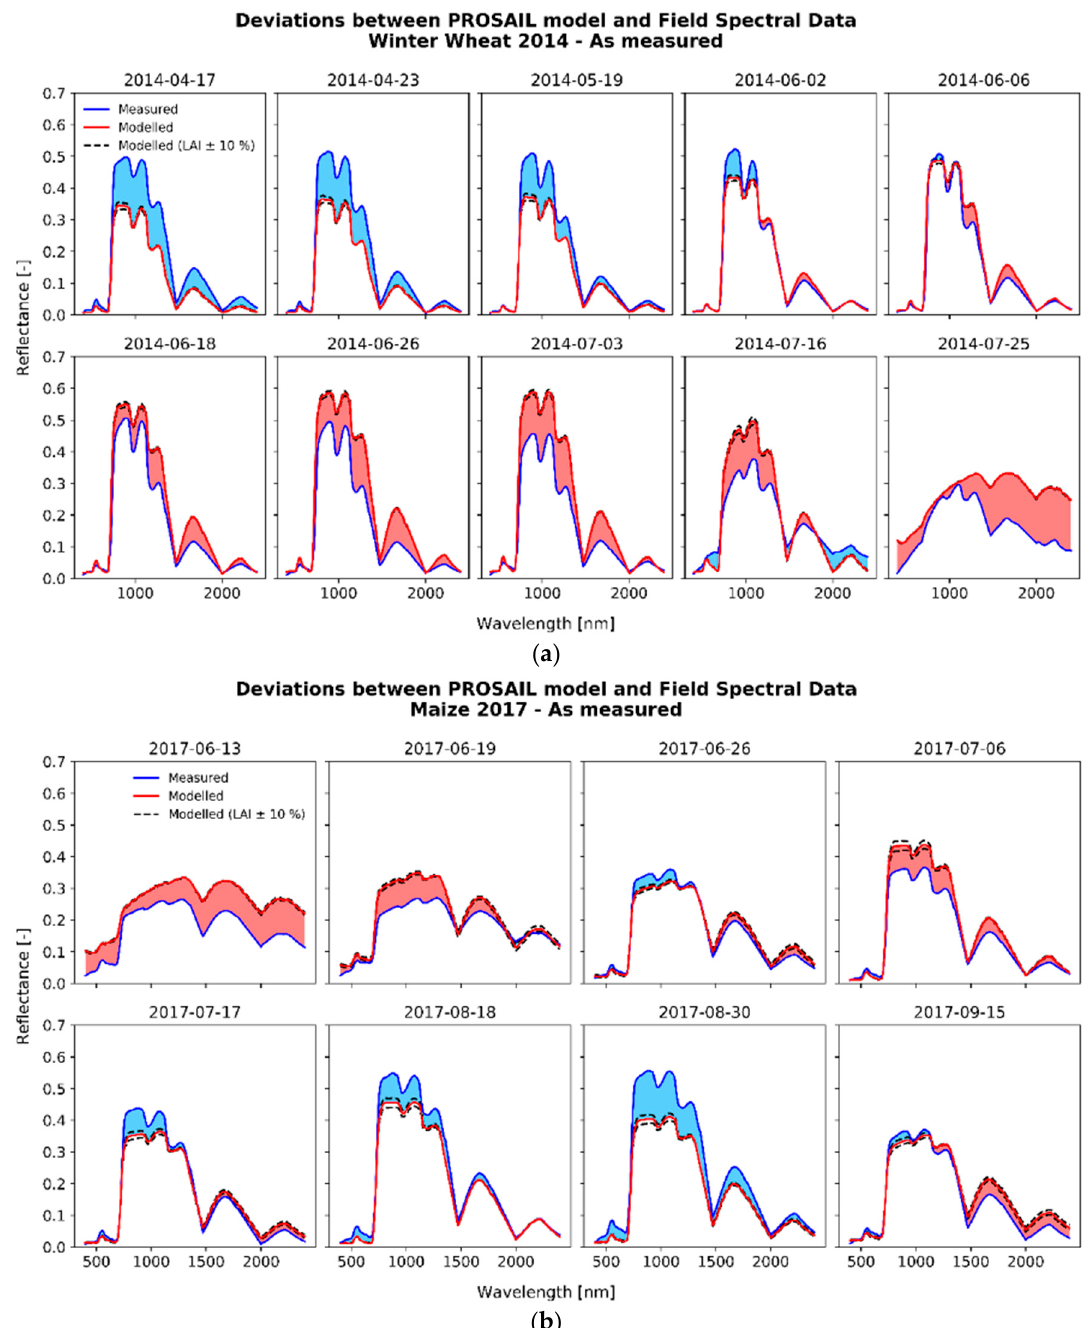
Figure 4. Spectral progression of winter wheat ( a ) and silage maize ( b ) canopies as shown for the seasons of 2014 and 2017, respectively. The measured spectra are drawn in blue, the PROSAIL output fed with in situ measured variables in red. The black dashed lines illustrate the model response to a ± 10% uncertainty of LAI.